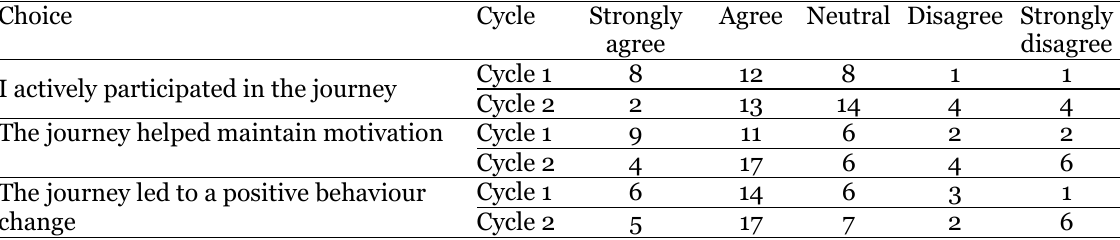
Agree Neutral Disagree Strongly agree disagree Cycle 1